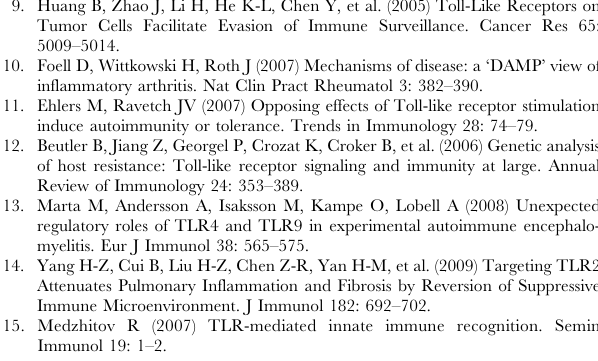
Figure S3 TLR2 mediated the HSP60 induced expressions of